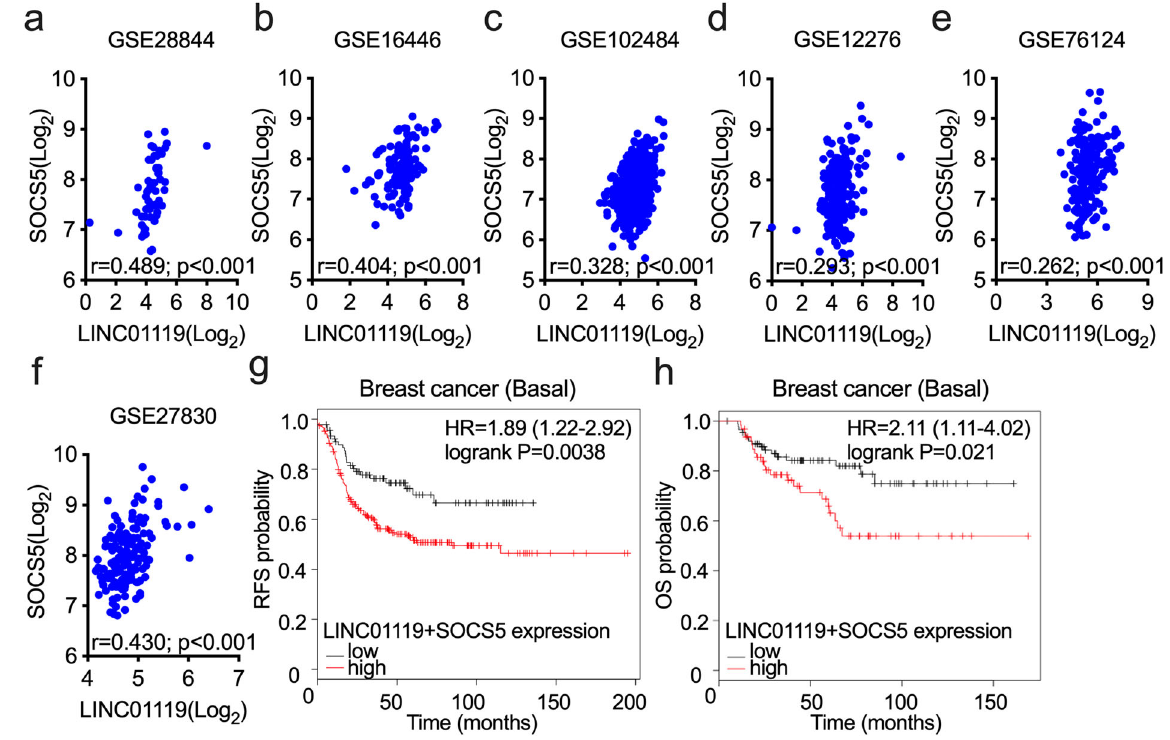
Fig. 7 LINC01119-SOCS5 pathway is prognostic of poor patient survival. a – f Correlation of LINC01119 and SOCS5 in GSE28844 ( a ), GSE16446 ( b ), GSE102484 ( c ), GSE12276 ( d ), GSE76124 ( e ), and GSE27830 ( f ). g Kaplan-Meier analysis (kmplot.com) of relapse-free survival (RFS) based on the mean value of LINC01119 and SOCS5 in basal breast cancer ( n = 544), the cutoff value of 301.5, probe 230799_at for LINC01119 and 209648_x_at for SOCS5. h Kaplan-Meier analysis of overall survival (OS) based on the mean value of LINC01119 and SOCS5 in basal breast cancer ( n = 248), the cutoff value of 438, probe 230799_at for LINC01119 and 209648_x_at for